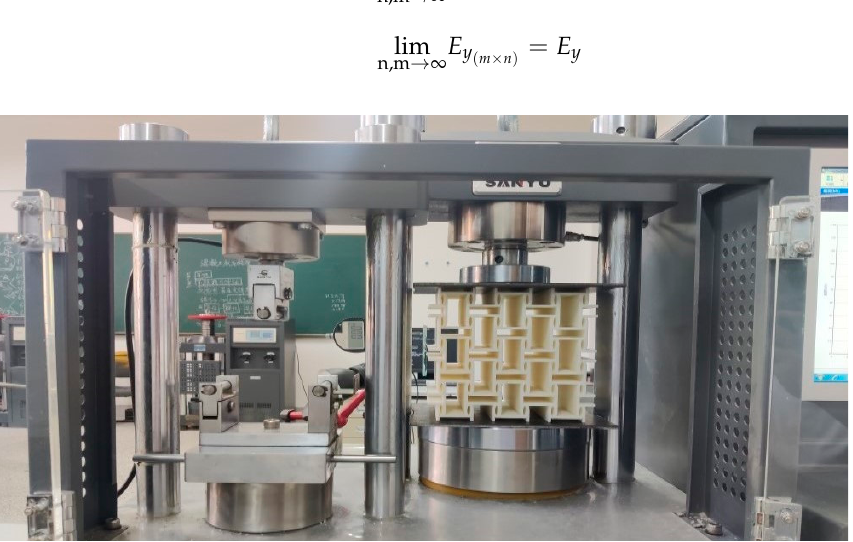
Figure 4. Experimental setup and sample. Table 2. Comparison of the results of theoretical derivations, FEM simulations and experiments. Theory FEM